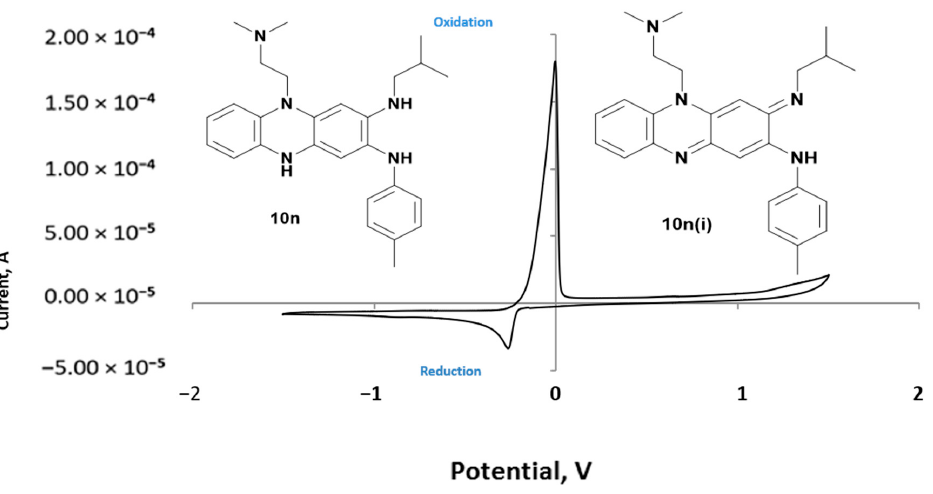
Figure. 3 Cyclic voltammogram (CV) of 10n . Figure 3. Cyclic voltammogram (CV) of 10n